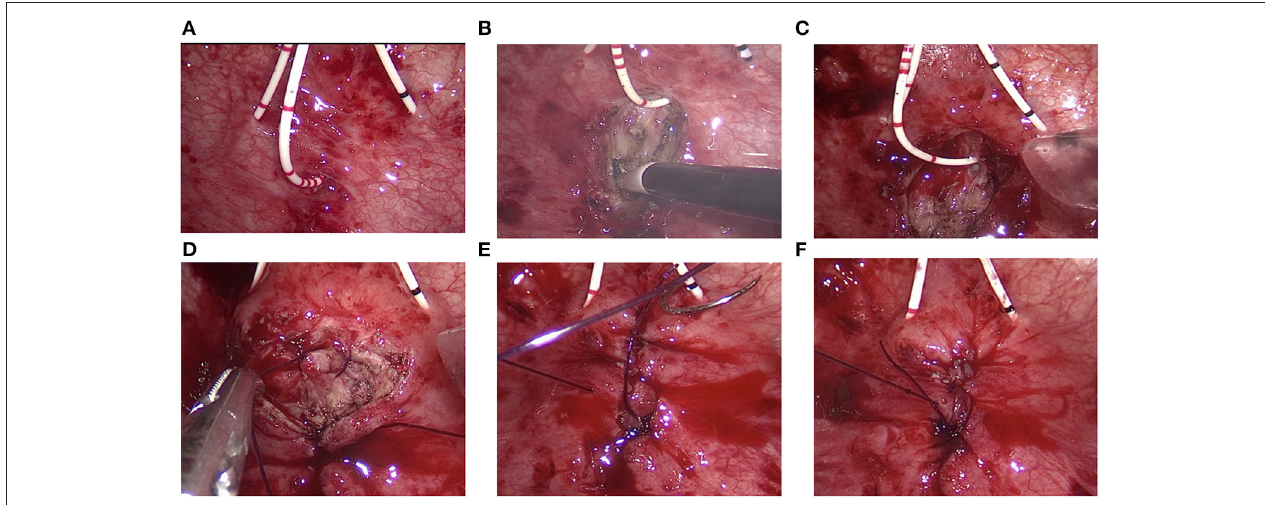
FIGURE 2 | Transvesical repair of vesicovaginal fistula. (A) Bilateral ureteral catheters were placed. Another ureteral catheter was inserted into the fistula tract. (B) The scar tissue was resected using a coagulation hook. (C) The bladder wall was widely mobilized off the vaginal wall. (D–F) The vaginal wall, bladder wall, and bladder mucosa were successively closed with 2-0 Monocryl suture.